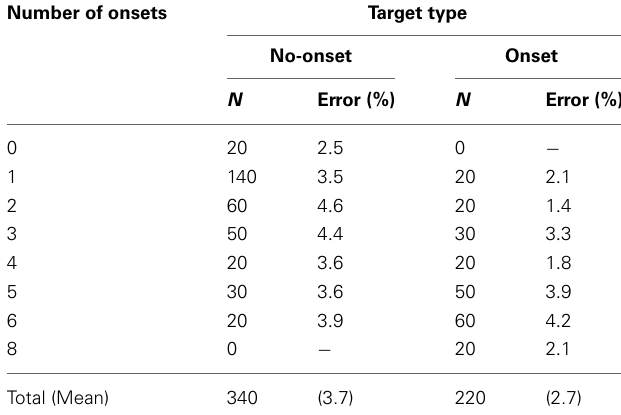
Table 3 | Number of trials ( N ) and mean percentage errors (%) for different target type and number of onsets in Experiment